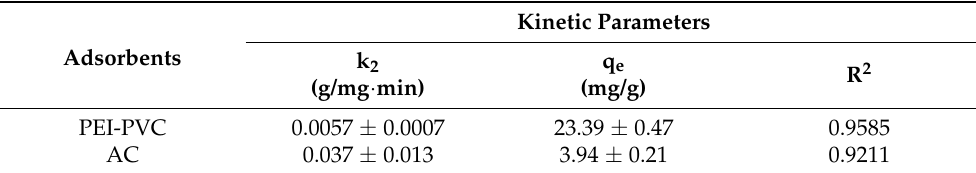
Table 2. Adsorption kinetic parameters of applied sorbents for phosphorus estimated from pseudo- second-order model at pH